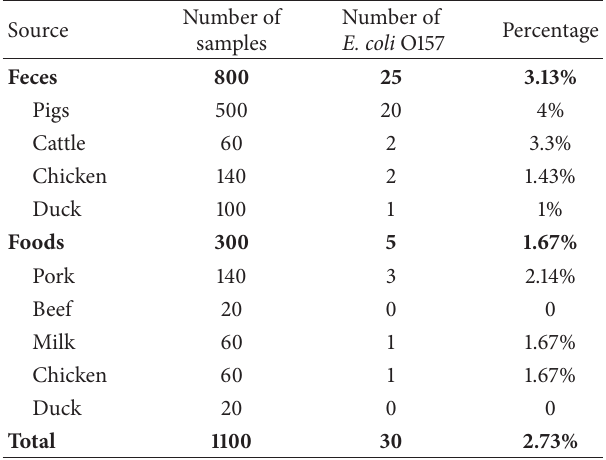
Table 2: Number of E. coli O157 identified from samples obtained from different